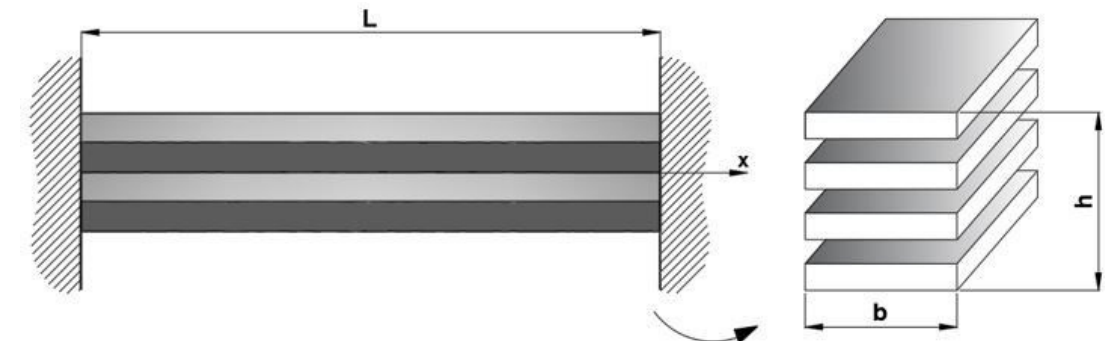
Figure 7. Clamped-Clamped (CC) laminated composite beam problem model.